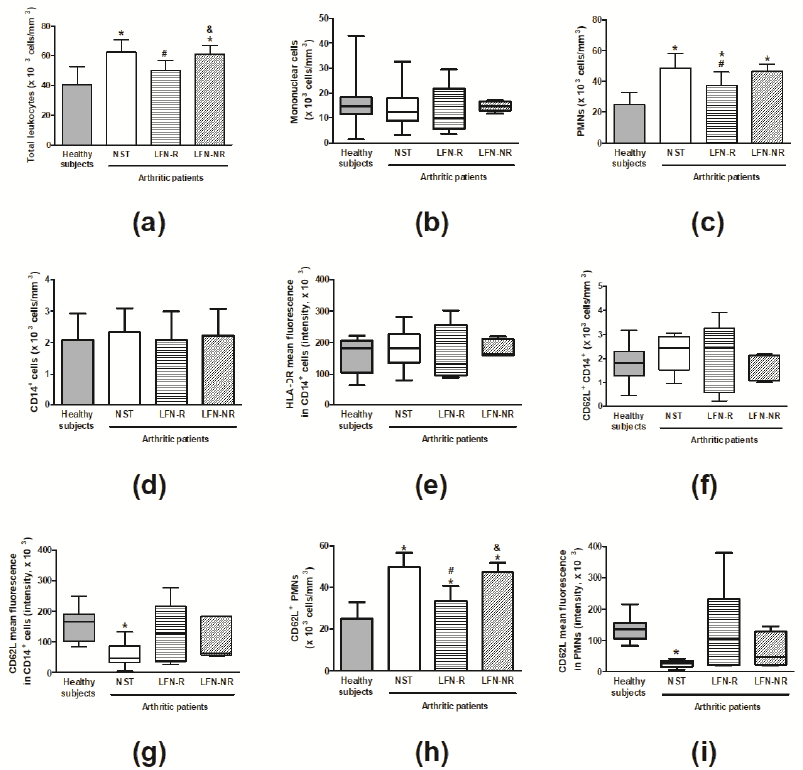
Figure 2. Flow cytometry analysis of peripheral blood cells. ( a ) Total leukocytes, ( b ) mononuclear and ( c ) polymorpho- nuclear (PMN) cells. Numbers of ( d ) CD14 + and ( f ) CD62L + CD14 + cells, and ( e ) HLA-DR and ( g ) CD62L mean fluores- cence in CD14 + cells. ( h ) CD62L + PMNs and ( i ) CD62L mean fluorescence in PMNs. Peripheral blood cells were isolated from patients recently diagnosed with rheumatoid arthritis (RA) but not yet receiving specific treatment with an- ti-rheumatic drugs, prior to leflunomide (LFN; 20 mg/day, per os ) treatment (NST group; n = 14). Three-months following treatment, samples were collected from both responders (LFN-R; n = 8) and non-responders (LFN-NR; n = 6) to LFN. Healthy subjects (n = 10) were used as controls. Data are expressed as mean ± SD (panels a , c , d and h ) or median and minimum-maximum values (panels b , e – g and i ). ∗ p < 0.05, differs from healthy subjects; # p < 0.05, differs from prior to therapy (NST group); & p < 0.05, differs from the LFN-R group.